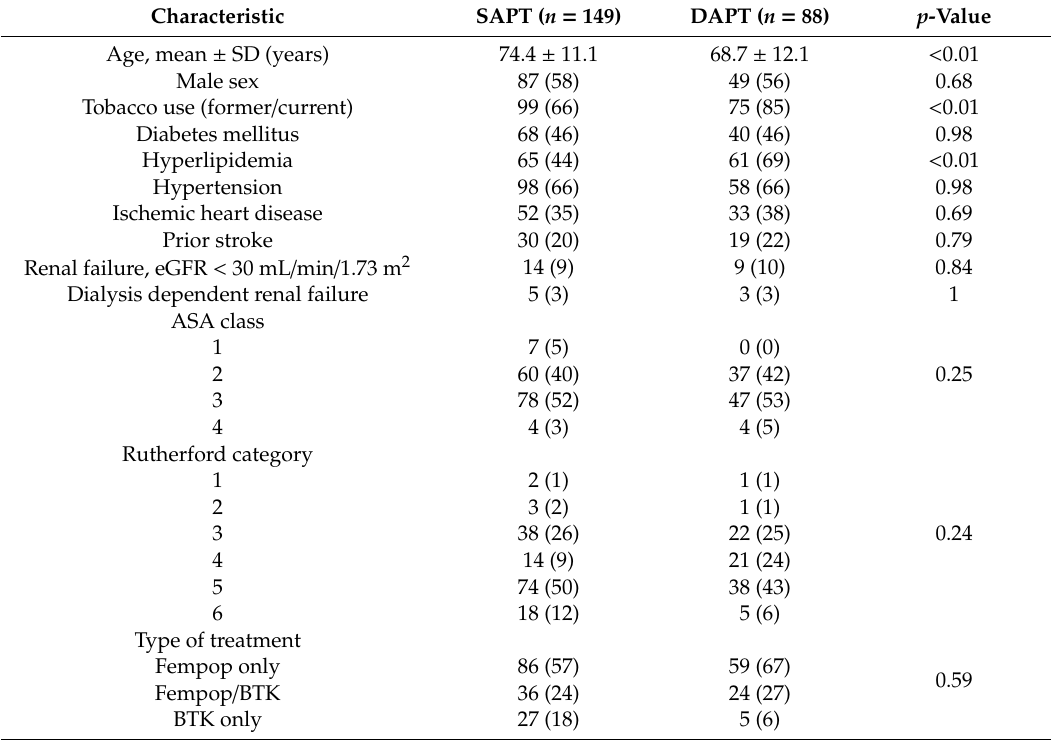
Table 2. Baseline characteristics per patient.